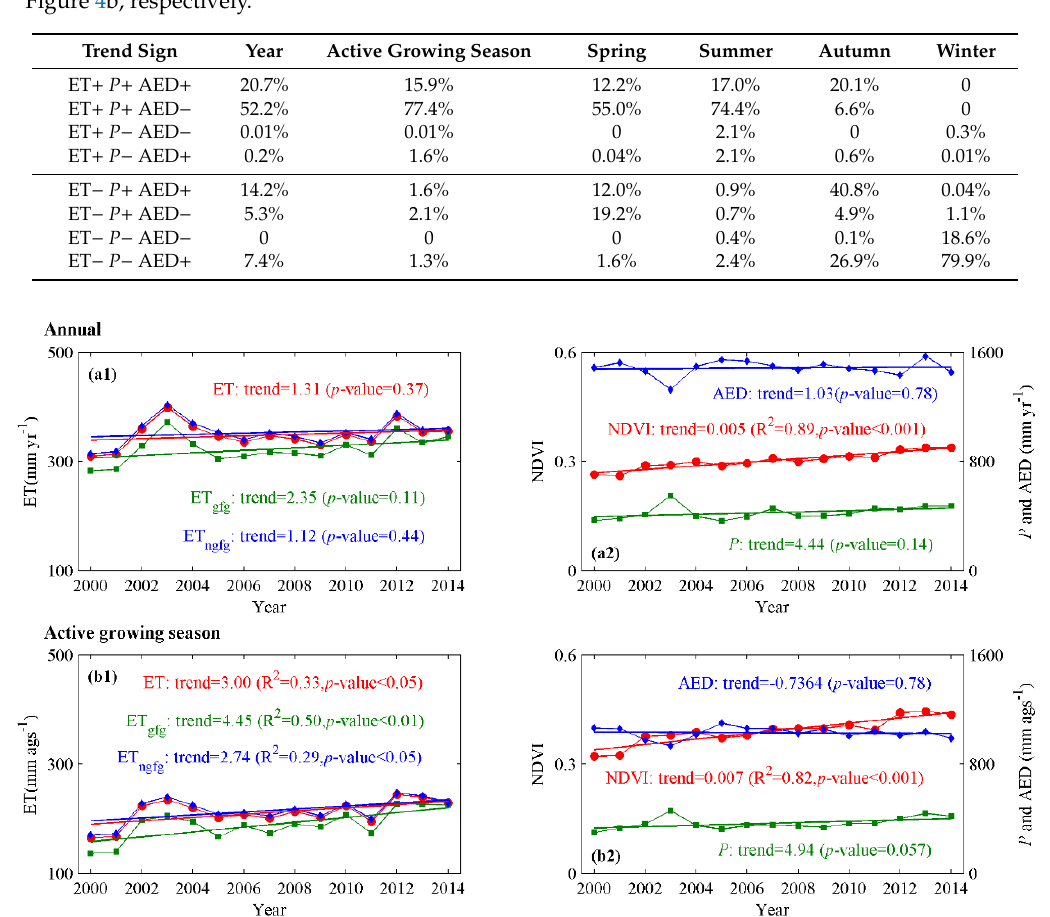
Table 3. Proportions of areas showing di ff erent variation signs of ET, P, and AED at di ff erent timescales in the CLP during 2000 − 2014. Symbols “ + ” and “ − “ indicate increasing and decreasing trends in Figure 4b, respectively.